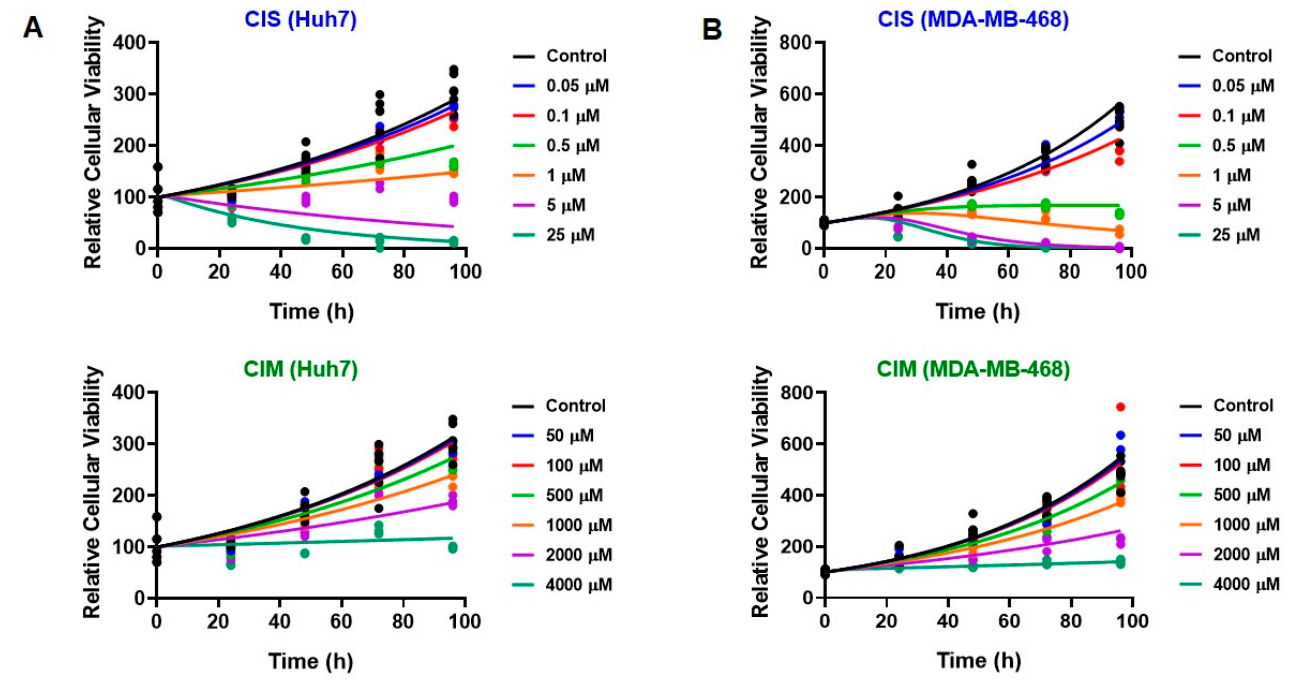
Figure 4. ( A,B ) Model fittings (using in vitro cell-level PD model) for the in vitro effects of the single agents, CIS (top) or CIM (bottom) at the indicated concentrations over time on the cell viability of human cancer cell lines, Huh7 ( A ) and MDA-MB-468 ( B ). Solid circles represent observed data while smooth lines are model fittings.